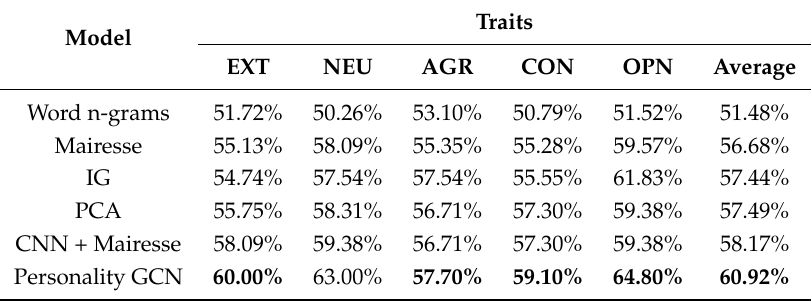
Table 6. Personality GCN classification results of accuracy on the essay dataset.